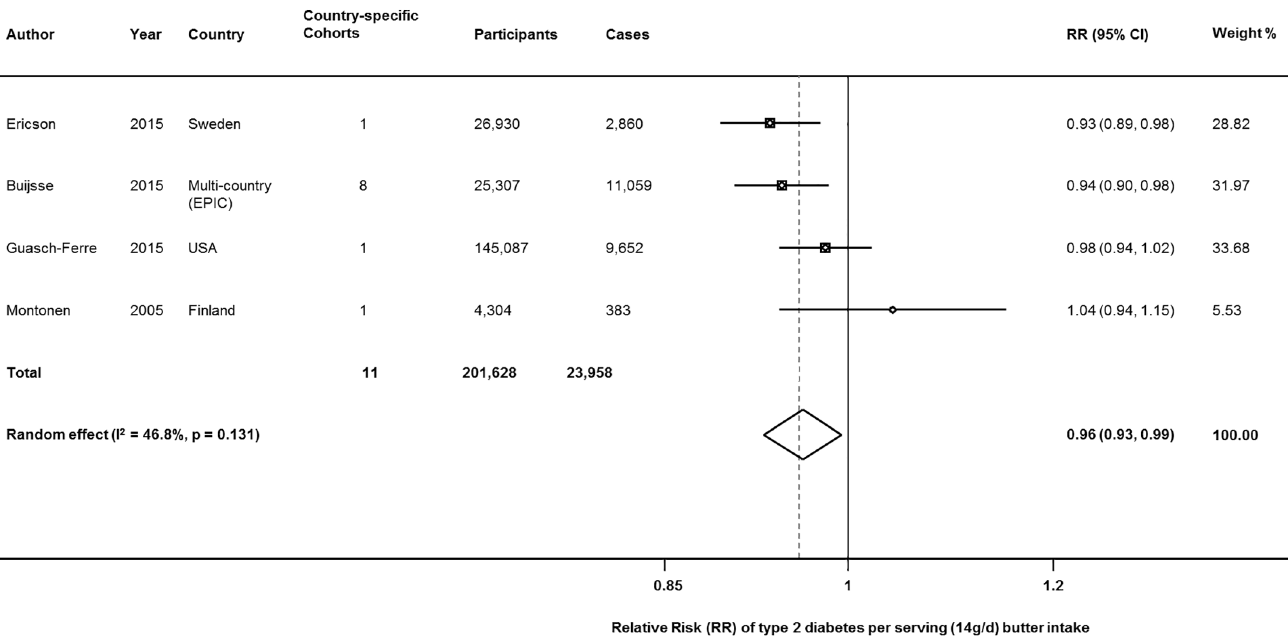
Fig 4. Butter consumption and risk of type 2 diabetes. Within-study dose-response RRs were derived from reported linear effects or generalized least-squares trend estimation for studies reporting categories of intake, a pooled using both inverse-variance weighted random and fixed effects